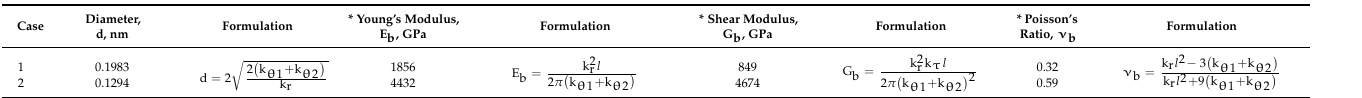
Table 2. Geometrical and elastic properties of the beams used as input parameters in FE simulations of InNNSs and